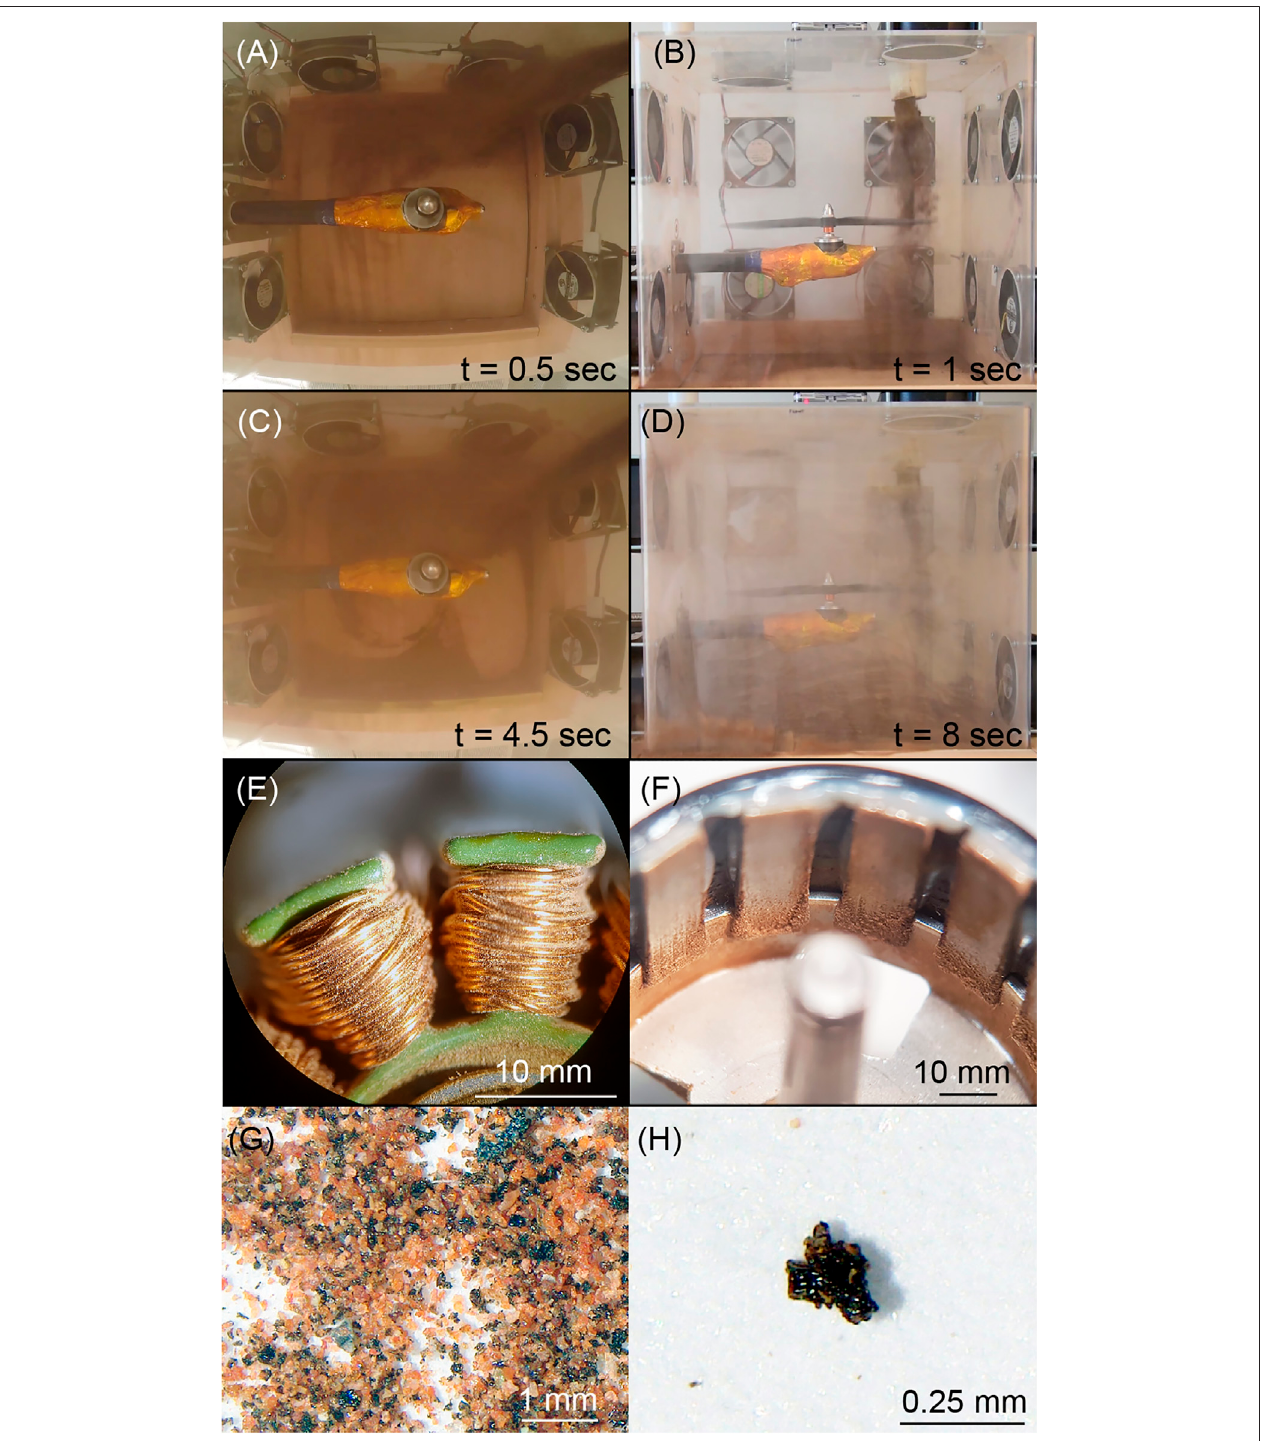
FIGURE 4 | Preliminary experimental results of ash-motor interactions. (A – D) Snapshots at four different times showing the ash entering the plexiglass cube and being incorporated into the turbulent air fl ow, generated by the rotating propeller and fans located at the sides of the cube. (E) Close-up image of the stator coils of the disassembled motor with a visible fi ne-ash layer deposited onto the wires. (F) Microscopy image of deposited volcanic material on the rotor magnets. (G) Collected volcanic material trapped inside the motor ( < 500 micron), showing several components (scoriaceous clasts, denser glass fragments and crystals). (H) Close-up view of a magnetic particle in the volcanic material sampled from the motor ’ s inside.